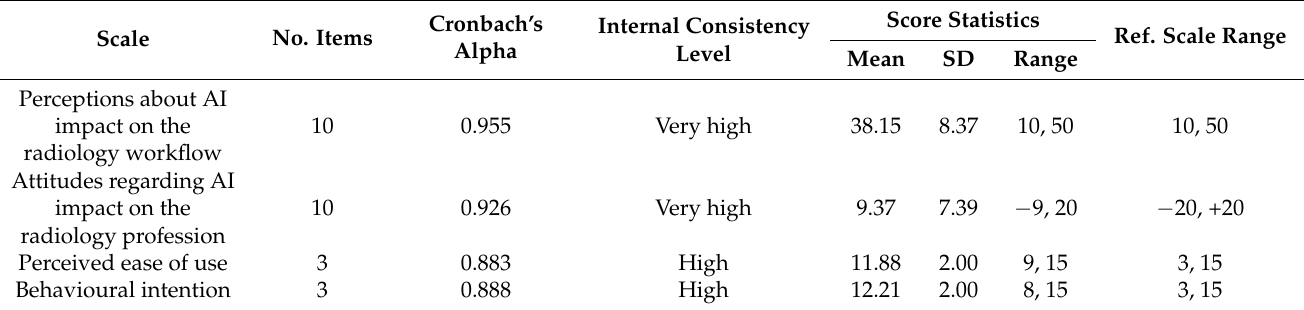
Table 3. Internal consistency of the four study scales.